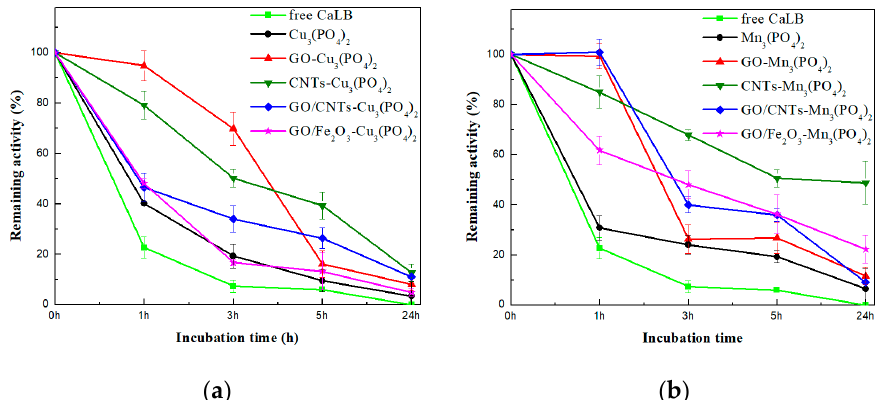
Figure 4. Thermal stability of: ( a ) Cu 3 (PO 4 ) 2 -based CaLB-HNFs and ( b ) Mn 3 (PO 4 ) 2 -based CaLB-HNFs at 60 °C. The 100% percentage corresponds to the activity at t = 0 min.